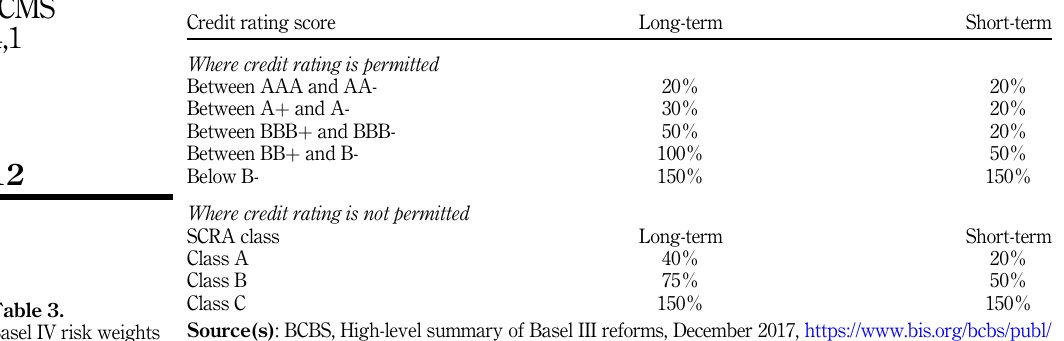
Table 3. Basel IV risk weights for banks